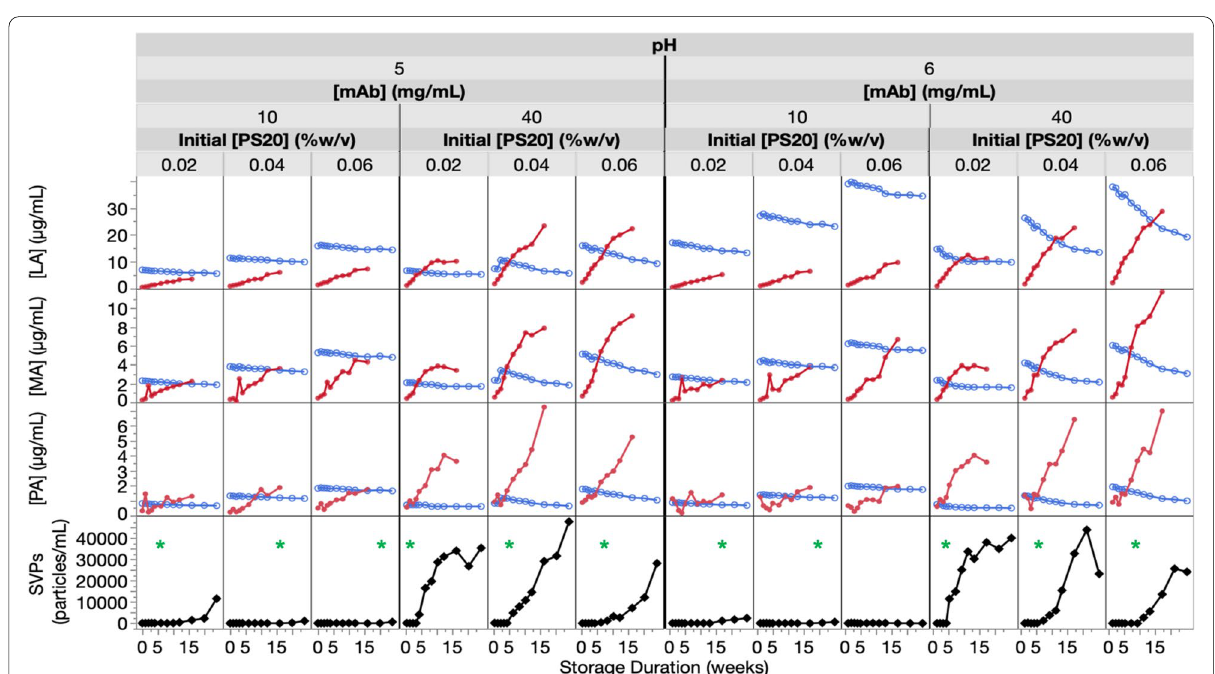
Fig. 12 Comparison of calculated FFA solubility limits (blue hollow circles) with corresponding FFA measurements (red filled circles), SVP counts (black filled diamonds), and VP observations (green asterisks) in mAb X DP stored at 5 °C. FFA solubility limits at the different time points for each formulation were calculated using the updated FFA solubility model by Doshi et al. (Doshi et al. 2020). Formulations were analyzed for LA, MA, and PA (by LC–MS), cumulative SVPs ( 2 µm particles/mL by HIAC), and VPs (by the Ph. Eur./USP method). Green asterisks (bottom panel) denote the ≥ earliest time points at which VPs were observed for the given formulation (Table